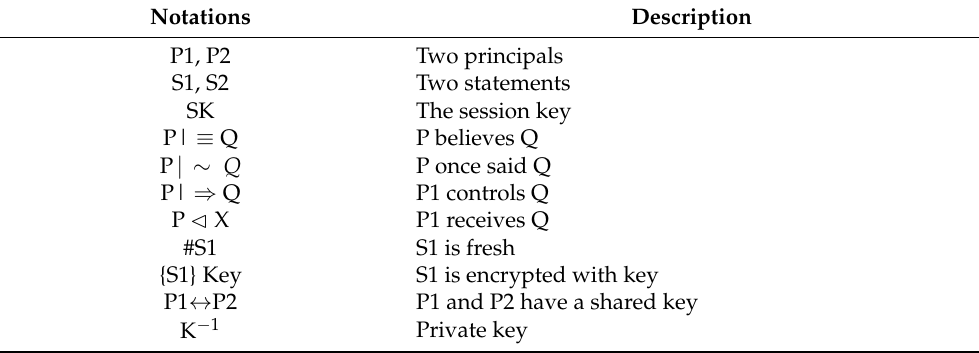
Table 8 summarizes the basic notations of the BAN logic used in this proof. Table 8. Notations of BAN logic adopted in the lightweight authentication MAC protocol for the